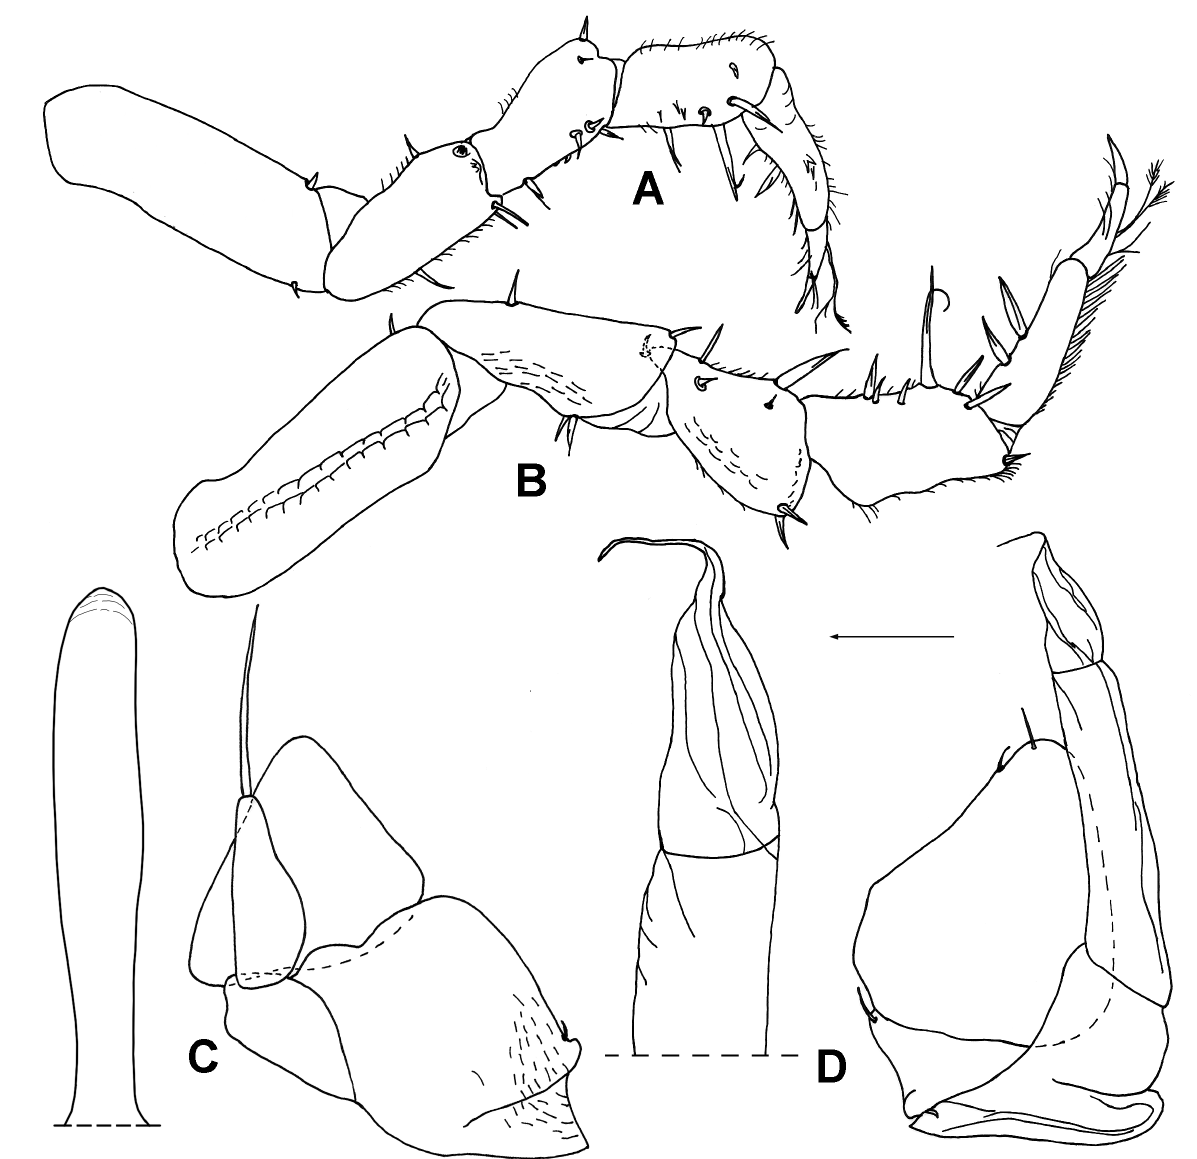
Fig. 17. Troglonethes arrabidaensis Reboleira & Taiti sp. nov. from Gruta do Frade, Arrábida, para- type, ♂. A . Pereopod 1. B . Pereopod 7. C . Genital papilla and pleopod 1. D . Pleopod